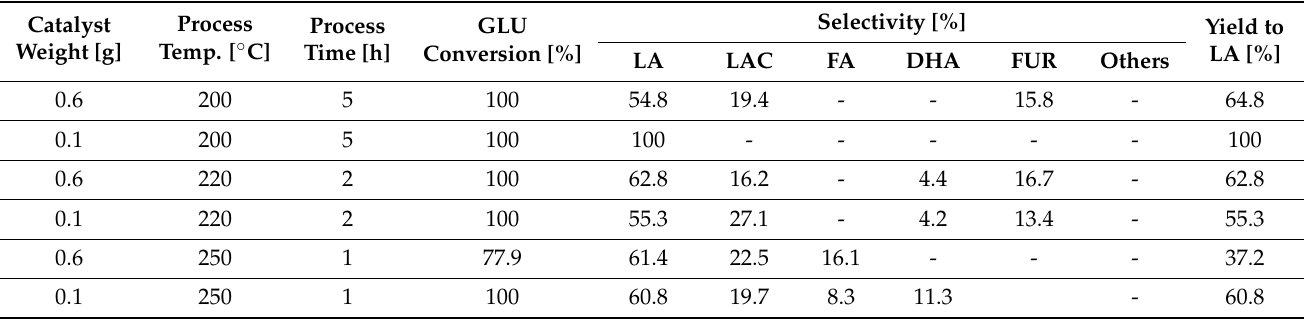
Figure 7. The results of HPLC analysis for the catalytic conversion of glucose over Na-BEA catalyst in the liquid phase for different process time and temperature: ( a ) 5 h and 200 °C; ( b ) 2 h and 220 °C; ( c ) 1 h and 250 °C. Table 4. The results of HPLC analysis for the catalytic conversion of glucose over Na-BEA catalyst in the liquid phase.